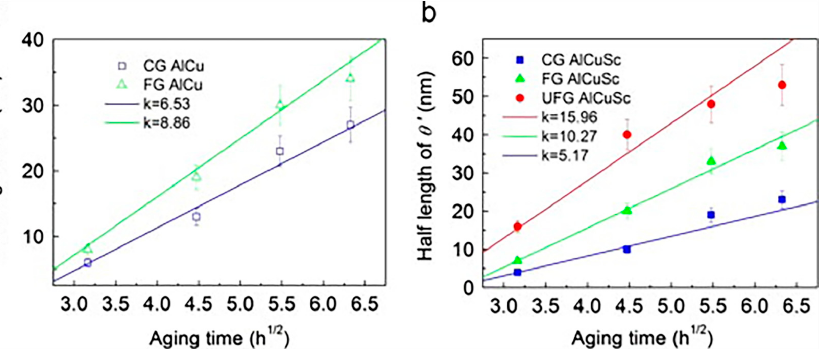
Figure 5. Growth kinetics of and experimental statistical results regarding the evolution of intra- granular θ′ -Al 2 Cu precipitate dimensions (half length) over time (t 1/2 ) aged at 398 K. ( a ) Sc-free alloys and ( b ) Sc-containing alloys